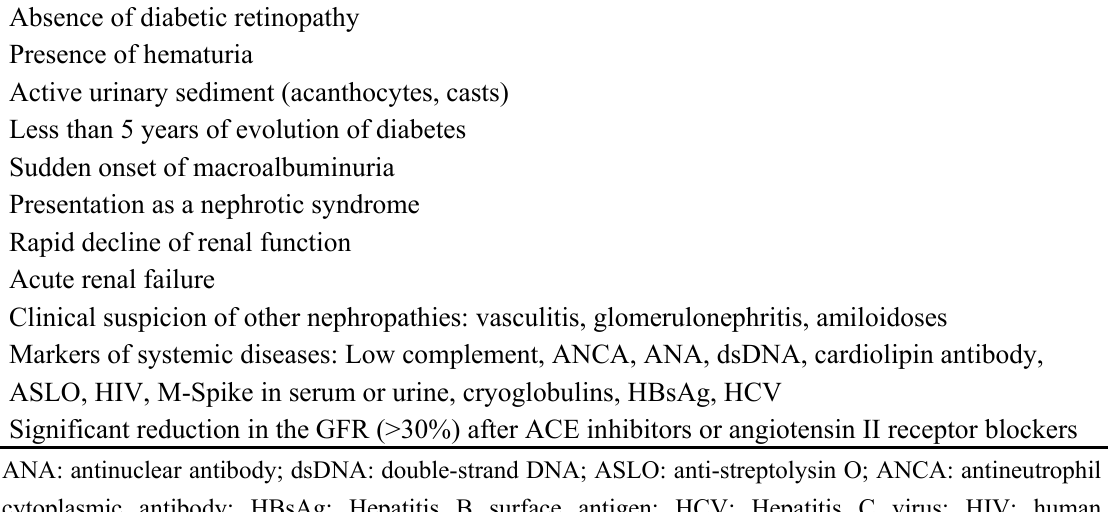
Table 1. Atypical presentation of renal disease in diabetic